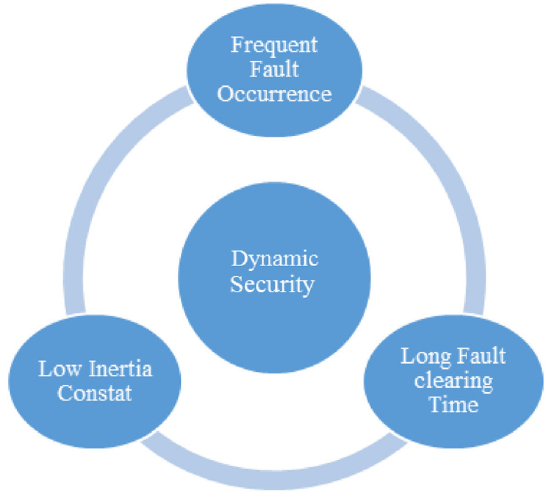
Fig. 1 The microgrid dynamic security